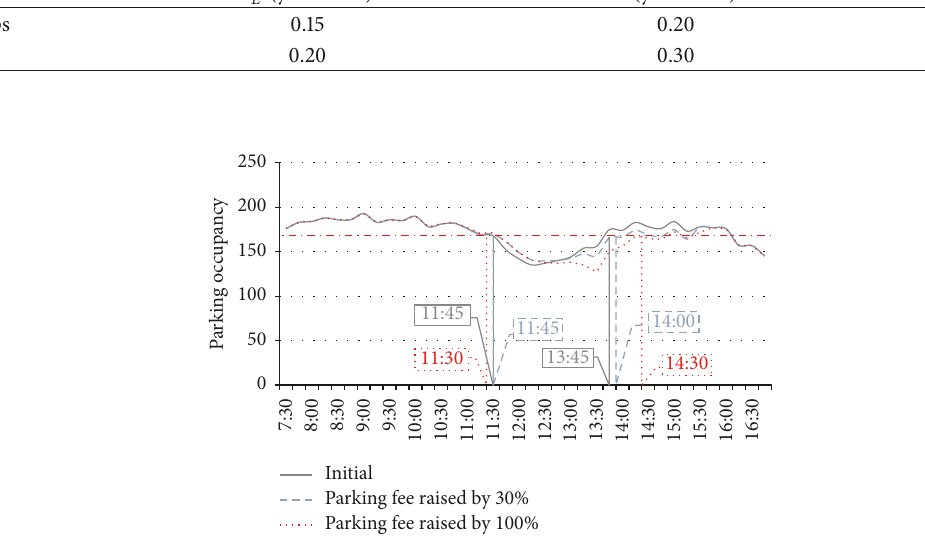
Figure 3: Time window after changing parking